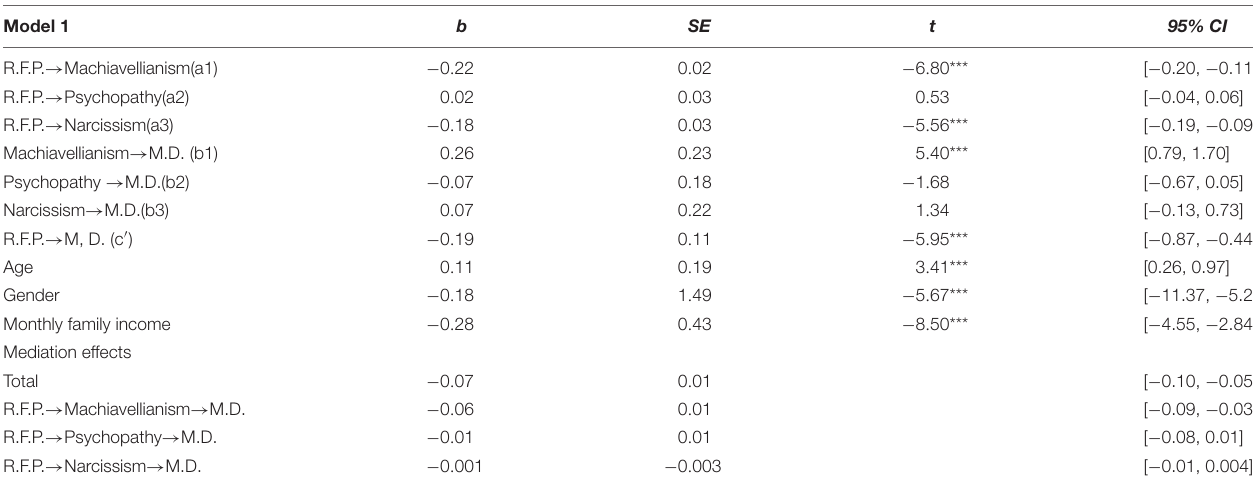
TABLE 2 | Mediation models of reciprocal filial beliefs ( N = 778). Model